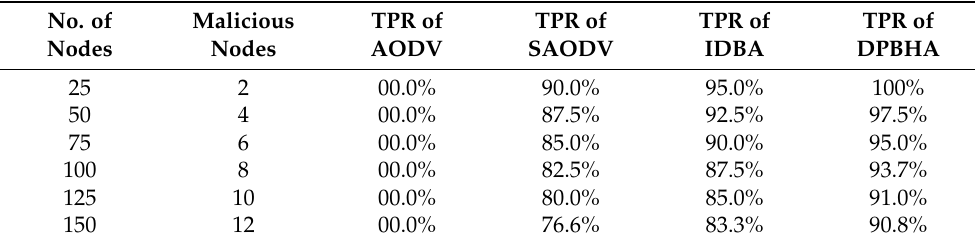
Table 7. Detection ratio evaluation